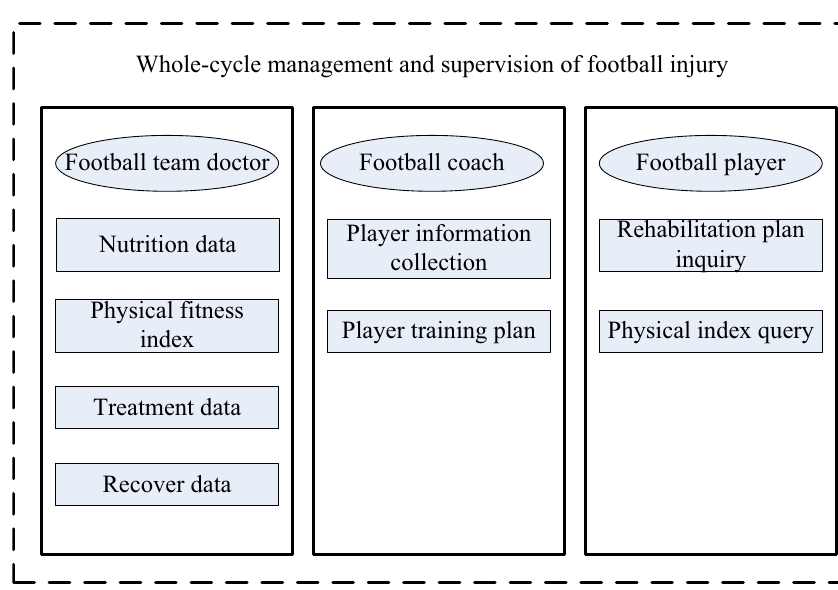
Fig. 1 Functional model of foot- ball injury full-cycle manage- ment and